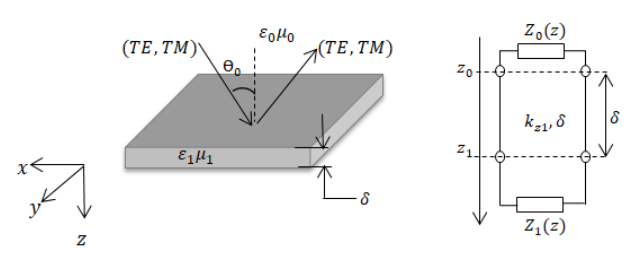
Figure 5. Two independent reflection